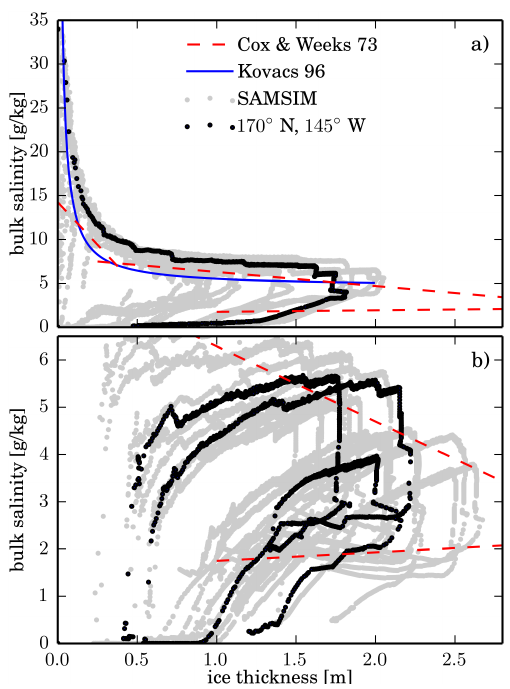
Figure 9. The vertically integrated vertical bulk salinity as a func- tion of ice thickness for all reanalysis forced runs as described in Sect. 4.1. Each grey dot represents a 12-hourly snapshot. (a) Con- tains all 15 years of first-year ice and (b) contains all 21 years of multiyear ice in grey. Of all nine simulations, a single simulation is plotted in black (80 ◦ N, 90 ◦ E) to enable tracking the evolution over time. The blue curve in (a) is the empirical relationship for first-year ice published by Kovacs (1997) for ice up to 2m. The red dashed lines mark the empirical linear relationships found by Cox and Weeks (1974) for growing (upper lines) and melting Arctic ice (lower